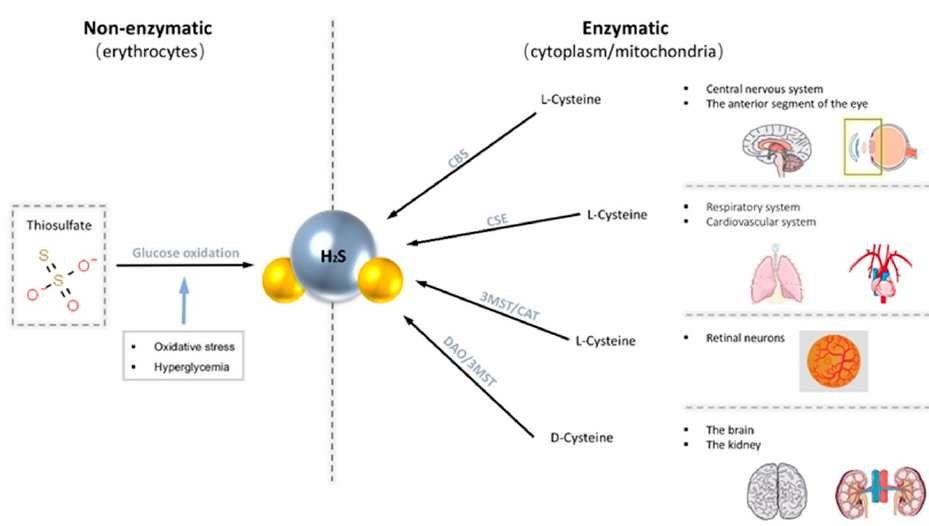
Figure 1. Endogenous H 2 S is produced through two main pathways, the non-enzymatic pathway and the enzymatic pathway. The non-enzymatic pathway is produced in erythrocytes via the glucose oxidation pathway. The enzymatic pathway promotes the production of H 2 S from cysteine with four common enzymes (cystathionine- β -lyase (CBS), cystathionine- γ -synthase (CSE), 3-mercapto-methylthio pyruvate aminotransferase (3MST), and cysteine aminotransferase (CAT)). These enzymes are distributed in various tissues of the body.